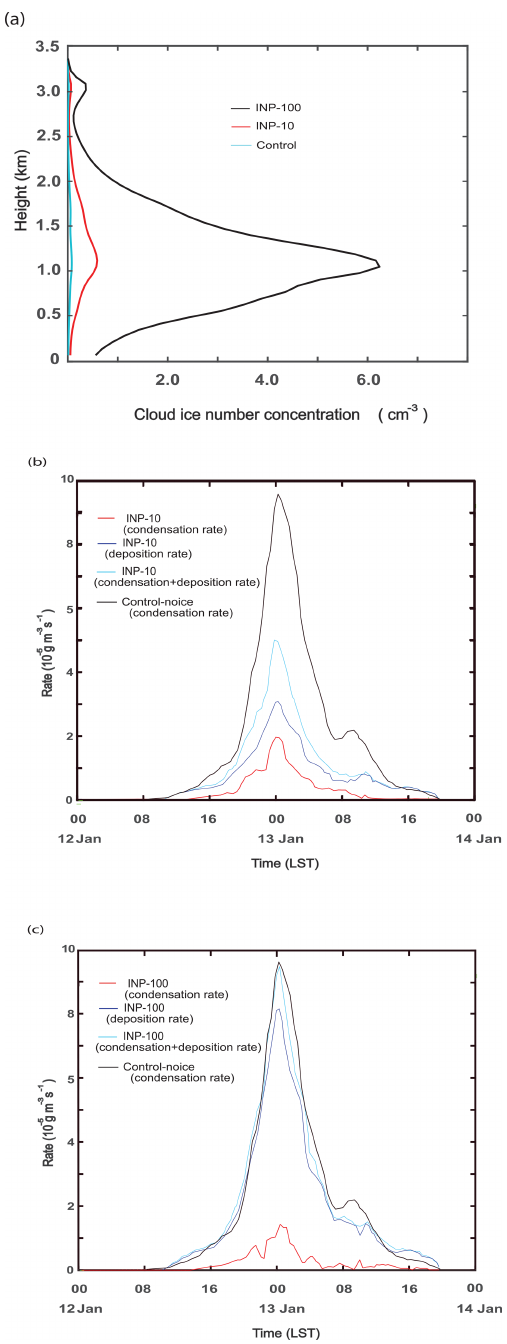
Figure 8. (a) Vertical distributions of the average CINC over grid points and time steps with non-zero CINC (for the whole domain and simulation period) in the control, INP-10, and INP-100 runs. Time series of the domain-averaged condensation rates, deposition rates, and the sum of those rates (b) in the INP-10 run and (c) in the INP-100 run. In (b) and (c) , condensation rates in the control-noice run are additionally